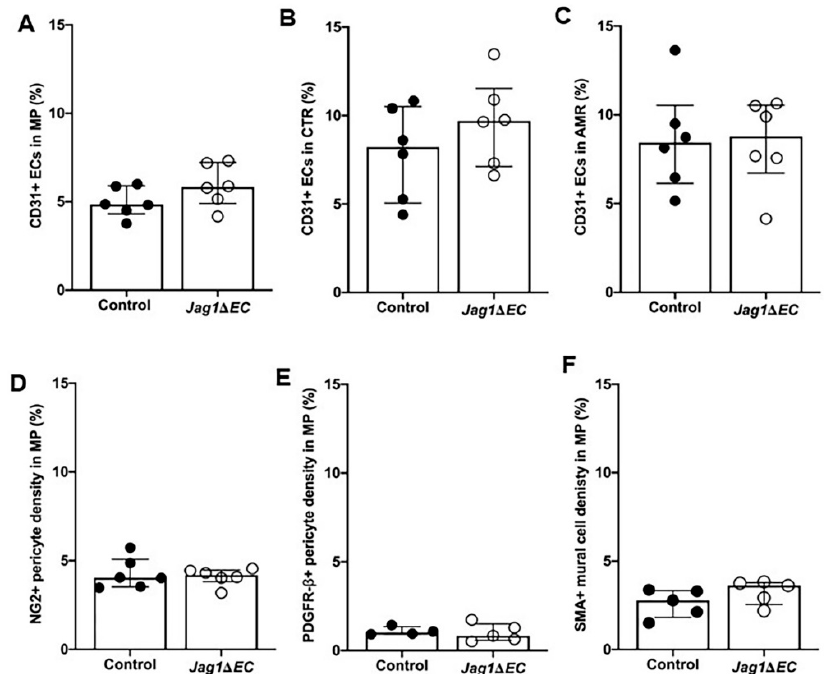
Figure 9. EC-specific loss of Jag1 does not impact endothelial and mural cell density. ( A – C ) Expression of CD31 + was quantified to determine blood vessel density in each region of the implantation site. ( A ) Density of CD31 + ECs was similar in Cdh5-Cre ERT2 control and Jag1 ∆ EC pregnancies in the MP (A) and CTR ( B ) of the MR and in the AMR ( C ). ( D – F ) Implantation sites stained for mural markers, NG2, PDGFR β or SMA are assessed for mural cell content at the MP. Expression of NG2 ( D ), PDGFR β ( E ) and SMA ( F ) is similar in Cdh5-Cre ERT2 control and Jag1 ∆ EC pregnancies in the MP. AMR = anti-mesometrial region; CTR = central region; MP = mesometrial pole; MR = mesometrial region. Data shown as median + IQR.